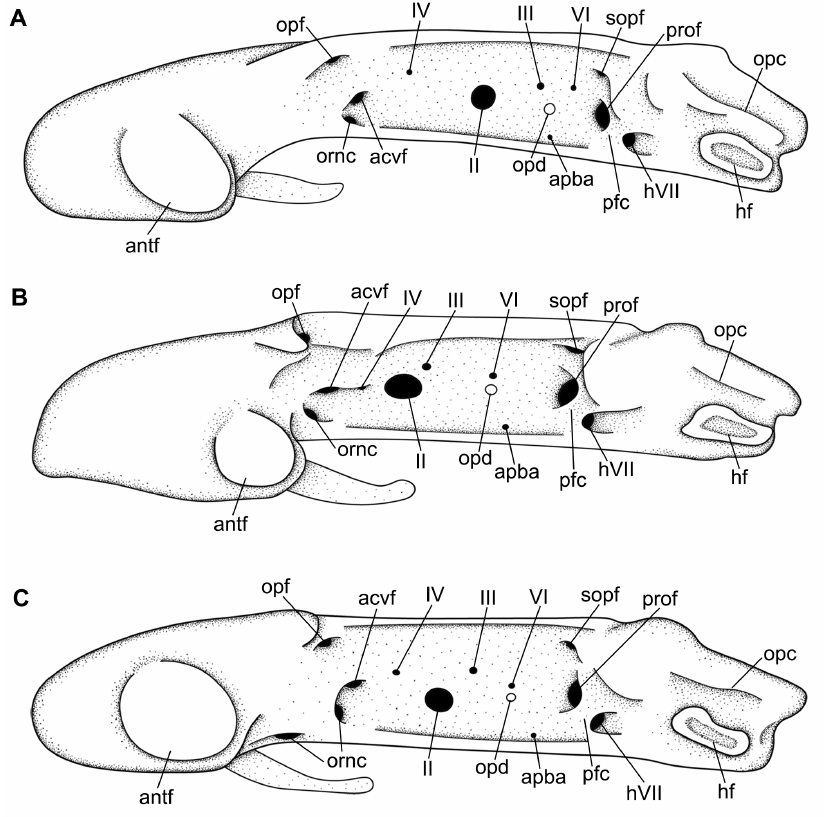
FIGURE 16 | Neurocranium of Atlantoraja species; lateral view. A , A. castelnaui , UERJ 1853, male, 593 mm TL. B , A. cyclophora , MNRJ 117184, female, 583 mm TL. C , A. platana , UERJ 1383, male, 372 mm TL. II , foramen for the optic nerve; III , foramen for the oculomotor nerve; IV , foramen for the trochlear nerve; VI , foramen for the abducens nerve; acvf , anterior canal vein foramen; antf , antorbital facet; apba , foramen for the afferent pseudobranchial artery; hf , hyomandibular facet ; hVII , foramen for the passage of the hyomandibular ramus of the facialis nerve; opc , opistotic crest; opd ¸ optic pedicel; opf , ophthalmic foramen; ornc oronasal canal; pfc , prefacial commissure; prof , prootic formamen; sopf , superficial ophtalmic